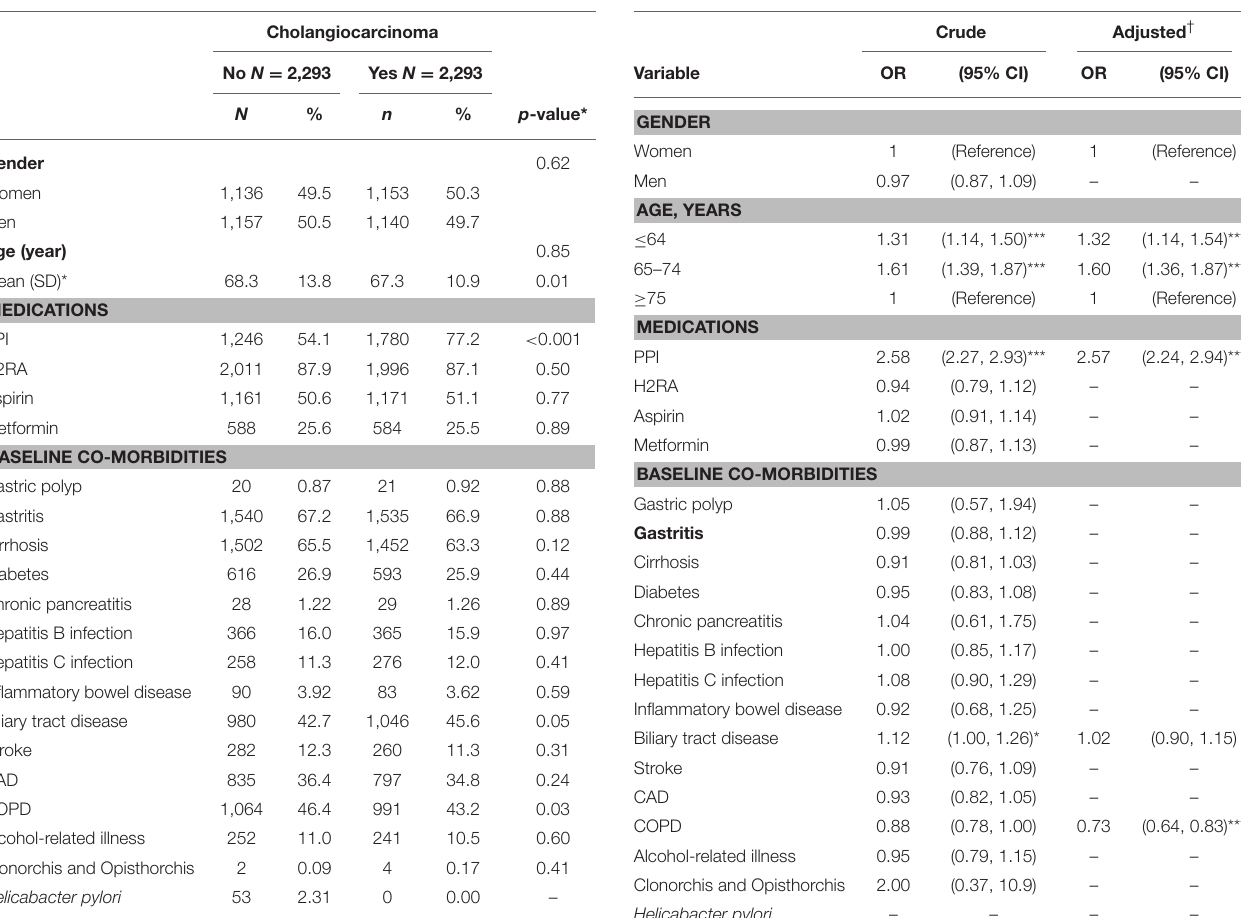
TABLE 1 | Baseline characteristics of cholangiocarcinoma group and non-cholangiocarcinoma group.